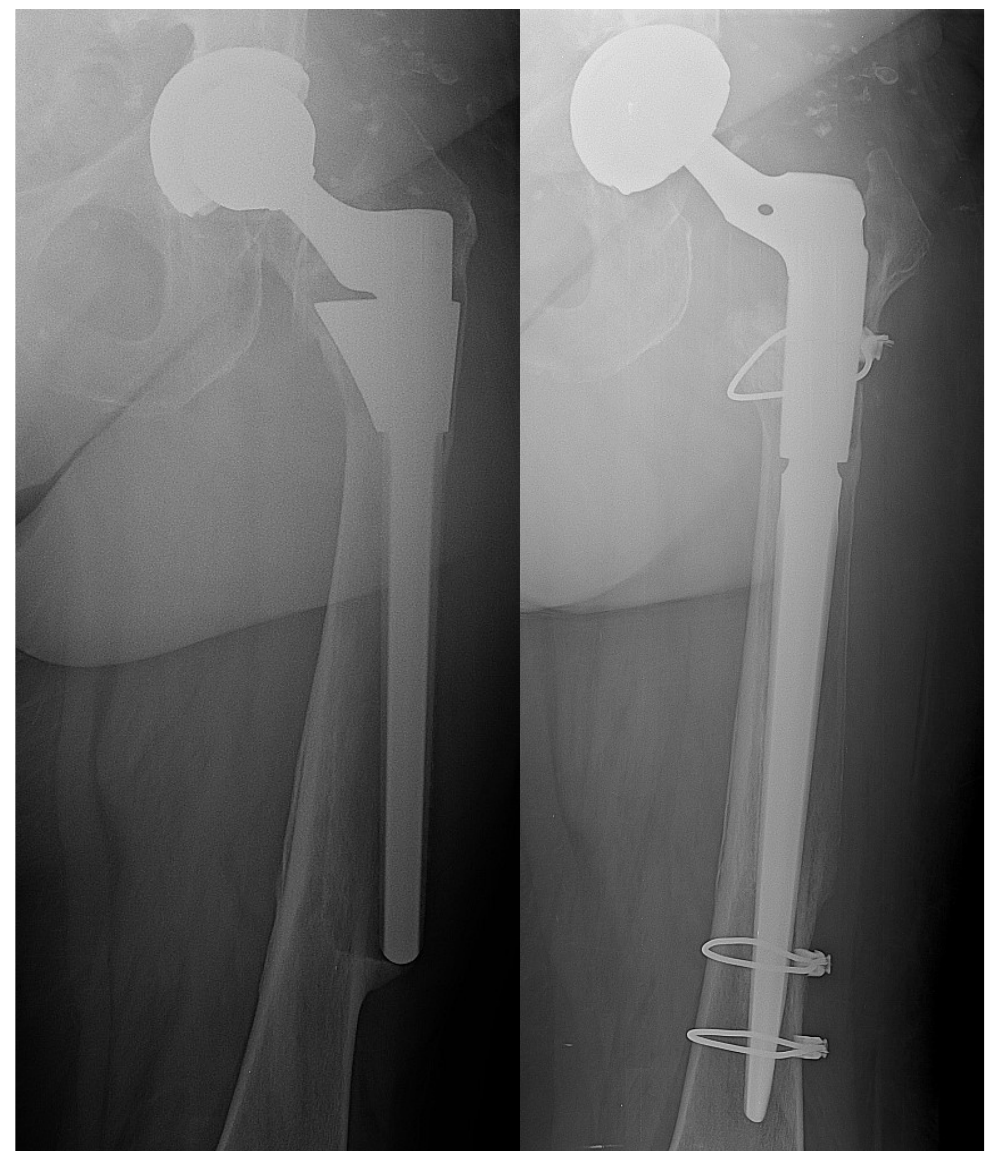
Figure 2. Aseptic loosening of femoral stem — stem and mobile components revision with hydrogel 176 antibacterial coating. On the left side preoperative X-ray; on the right side five months postoperative 177 follow-up. 178